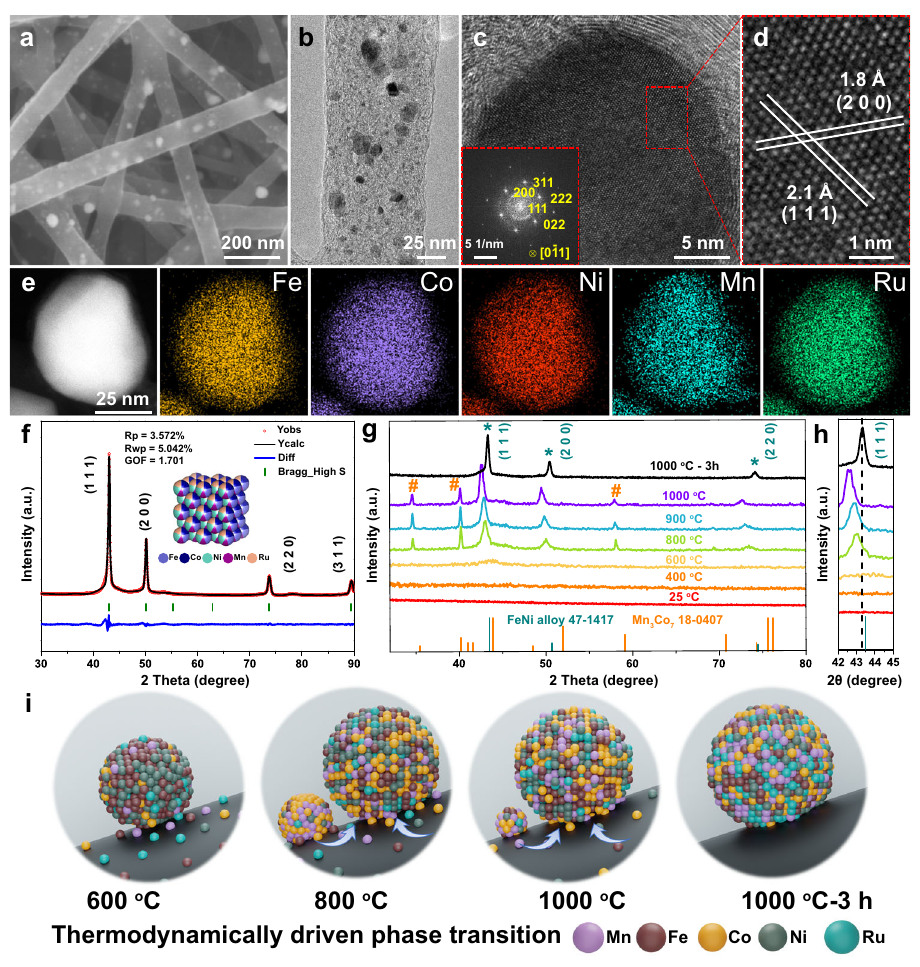
Fig. 2 Morphological and structural characterization of FeCoNiMnRu/CNFs. a FE-SEM, b TEM and c , d HRTEM images of FeCoNiMnRu/CNFs. The inset in ( c ) is the corresponding FFT pattern of a FeCoNiMnRu HEA NP. e HAADF-STEM and the corresponding STEM-EDX mapping images of a FeCoNiMnRu HEA NP supported on CNFs. f XRD patterns of FeCoNiMnRu/CNFs with detailed Rietveld re fi nements. g Real-time in situ XRD patterns for FeCoNiMnRu/ CNFs with temperatures ranging from 25 to 1000 °C. h The corresponding enlarged in situ XRD patterns of FeCoNiMnRu/CNFs. The heating rate was kept at 30 °C min -1 during the whole process. i The thermodynamically driven phase transition of FeCoNiMnRu NPs in CNF nano fi ber